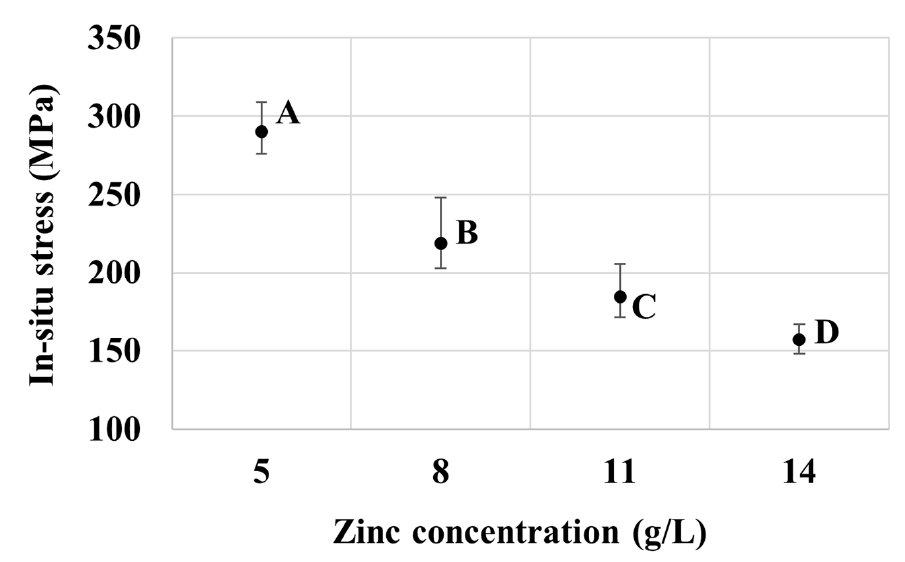
Figure 5. Effect of zinc concentration on the in-situ internal stress of samples from baths A, B, C, and D.